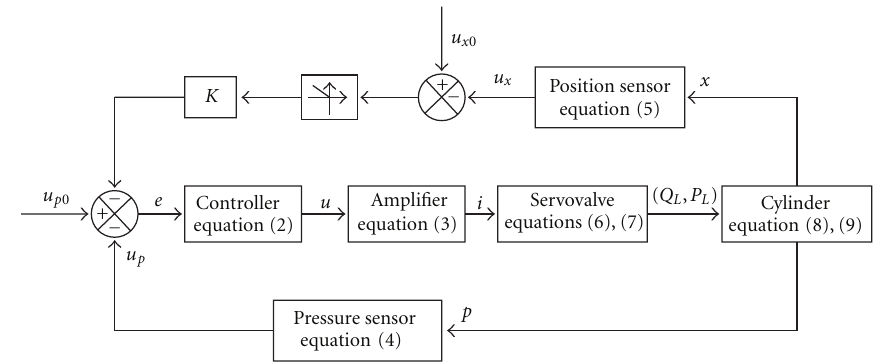
Figure 5: Block diagram of hybrid pressure/position control system.